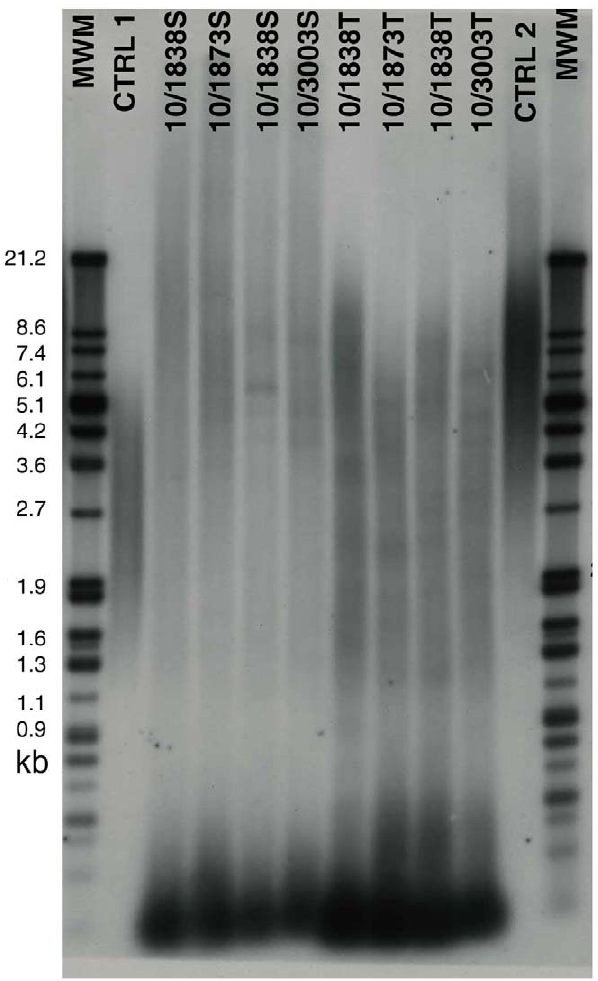
Figure 1. The Telomere Restriction Fragment Length analysis of devil samples revealed the presence of restriction enzyme recognition sites intercalated between the telomeric (TTAGGG)n sequences, preventing an accurate estimate of TRF lengths. Sample names depict the time of collection (10=2010). Identical numbers represent different tissue samples collected from the same animal, S depicts spleen and T depicts DFT samples. MWM stands for molecular weight markers. CTRL 1 indicates low molecular weight control DNA (length: 3.2 kbp), CTRL 2 indicates high molecular weight control DNA (length: 10.2 kbp). Control samples were supplied in the Telo TAGGG TL Assay Kit and originated from immortal cell lines.